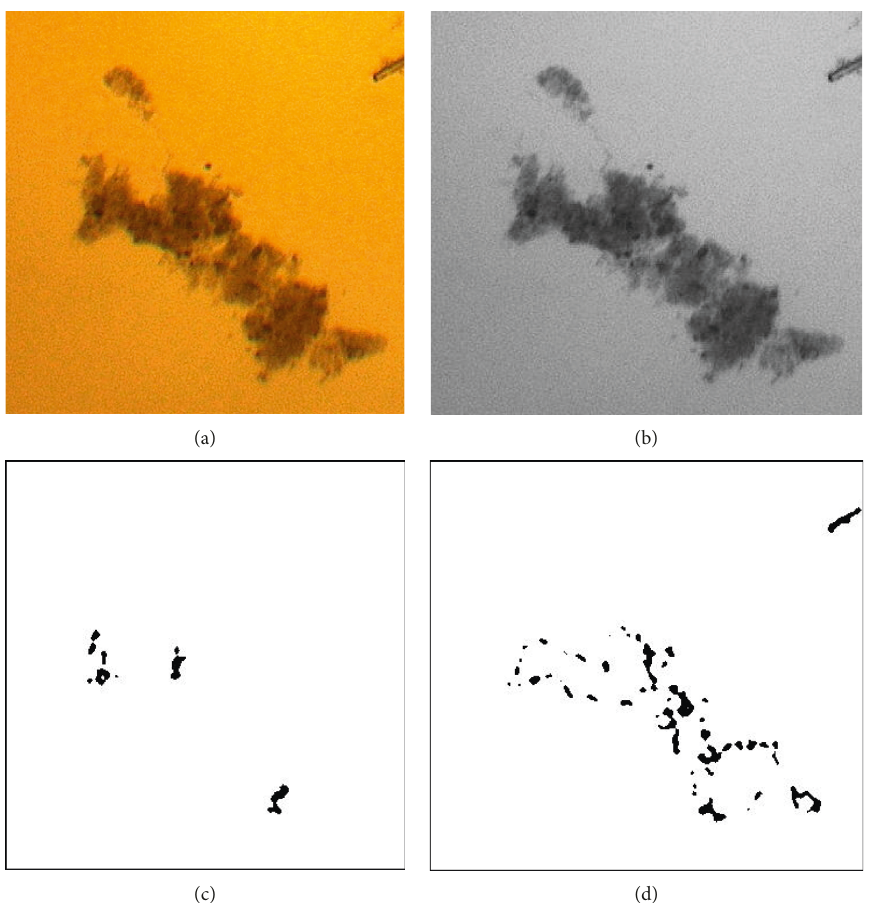
Figure 7: Image 4 segmentation results: (a) original image, (b) grayscale image, (c) segmentation results using Canny, and (d) segmentation results using our